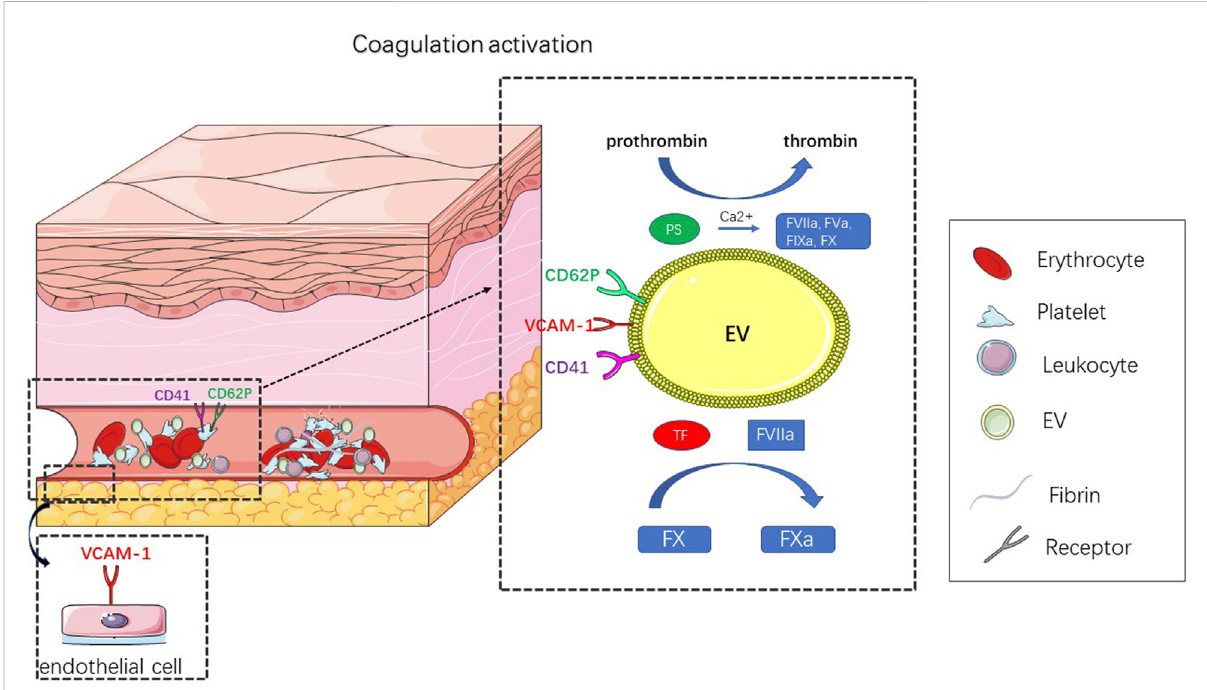
Title: Schematic diagram of EV leading to thrombosis. Thrombosis results from abnormal coagulation activation. In response to external stimulation, platelets, endothelial cells, erythrocyte and leukocyte can produce EV, that activate coagulation. The mechanism of